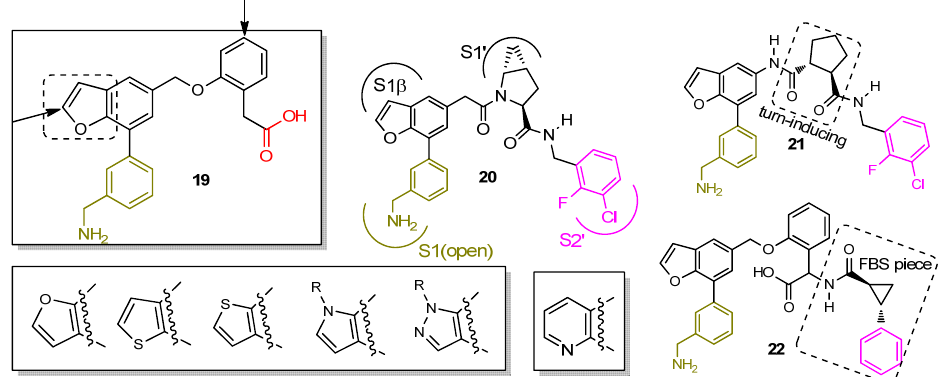
Figure 10. Benzofuran analogs ( US2019/0345135 , Biocryst) of potent and selective FD inhibitor 18 . Analogs 20 and 21 appear to be hybrid structures of potent FD inhibitors 7 and 19, while 22 is built based on inhibitors 19 and 9 . All analogs shown are reported to inhibit FD activity in the respective thioesterolysis assay with an IC 50 < 1 µM.